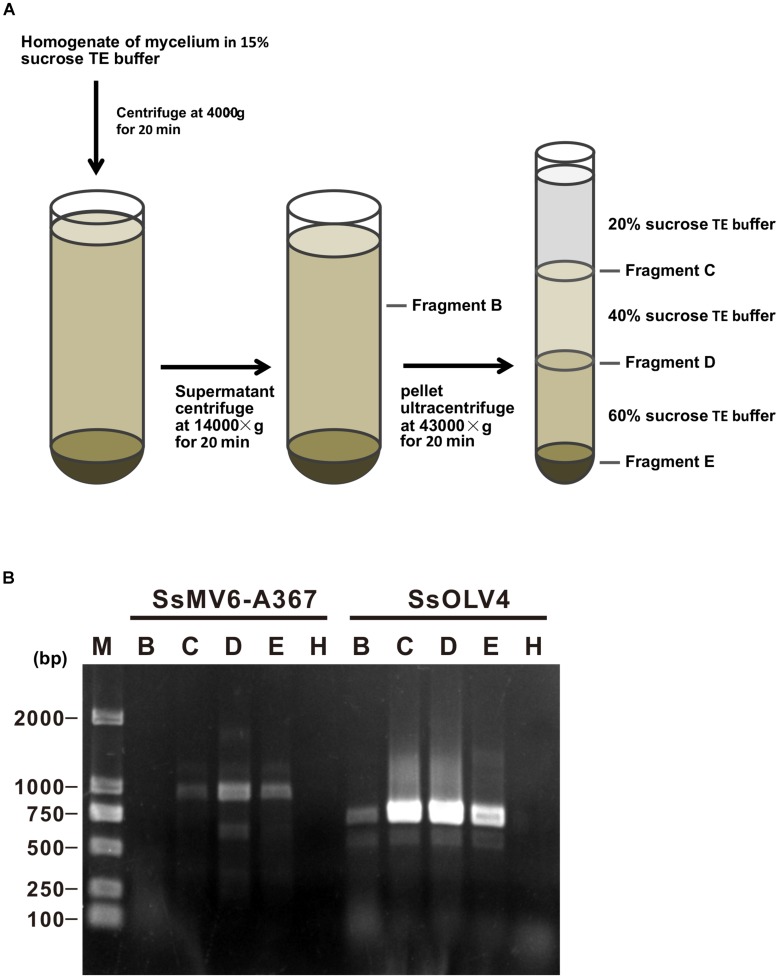
Detection of SsOLV4 and SsMV6-A367 in the cytoplasm and mitochondria of strain Ep-1PNA367P. Each fraction was purified and detected using RT-PCR. (A) Schematic diagram for isolating mitochondria. (B) RT-PCR detection of SsOLV4 (primers OMVF and OMVR) and SsMV6-A367 (primers MTVB400F and MTVB1346R).